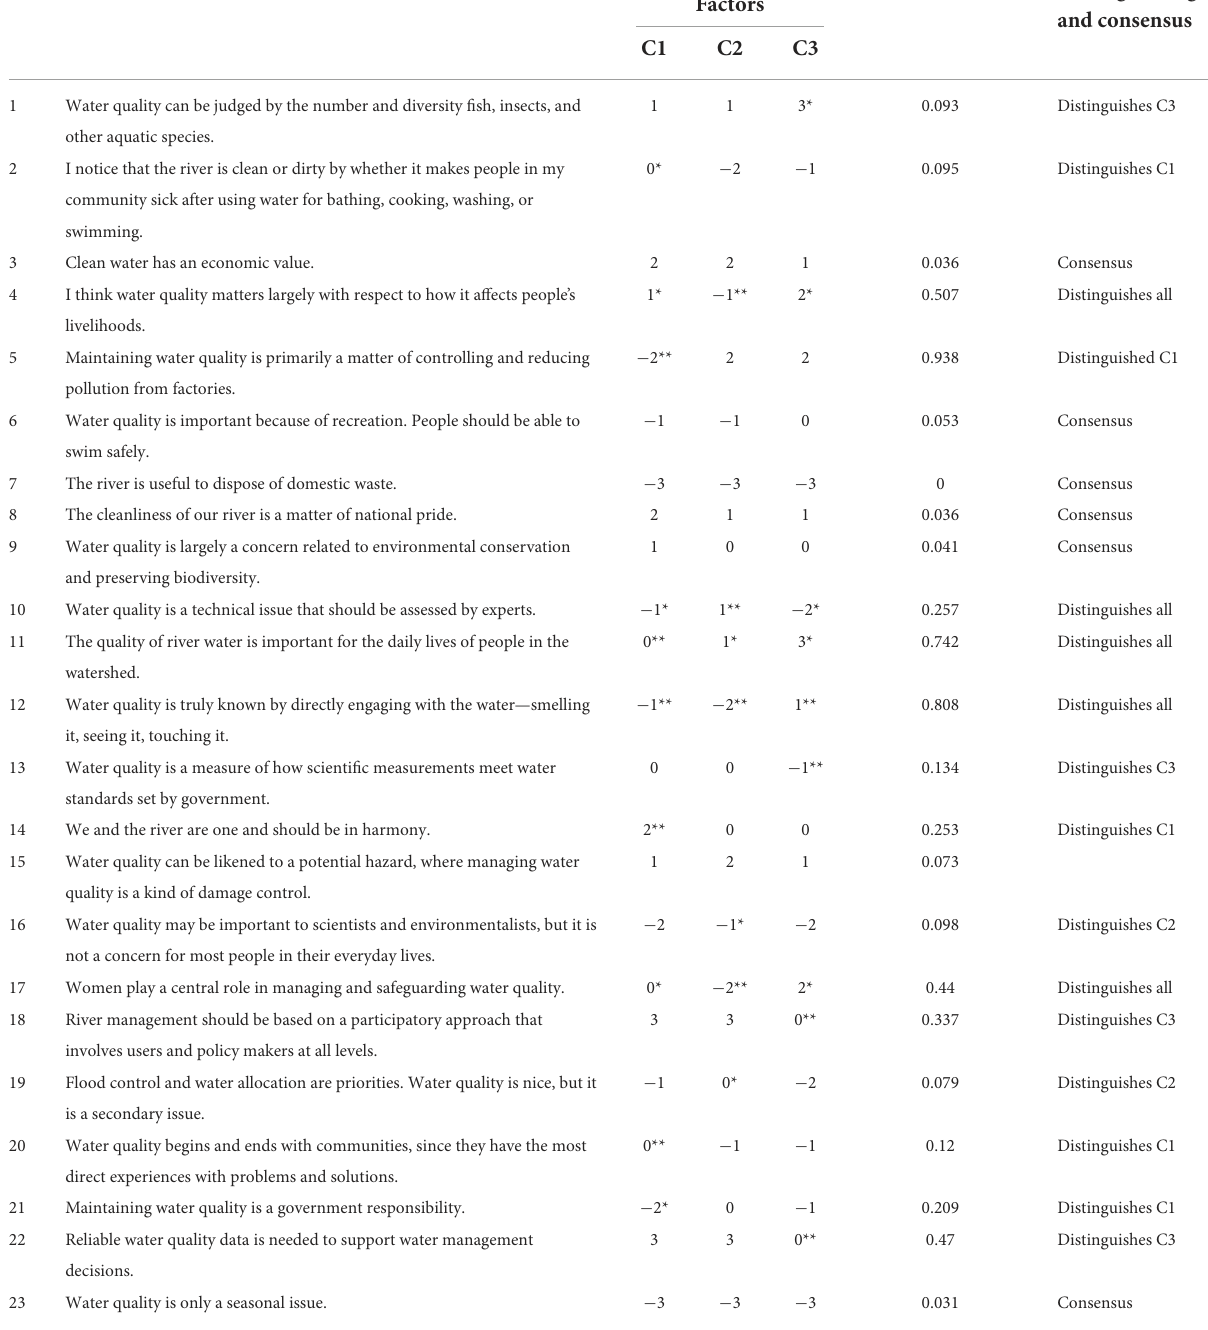
TABLE 5 Q-sort statement rankings for idealized Concept factor statements.